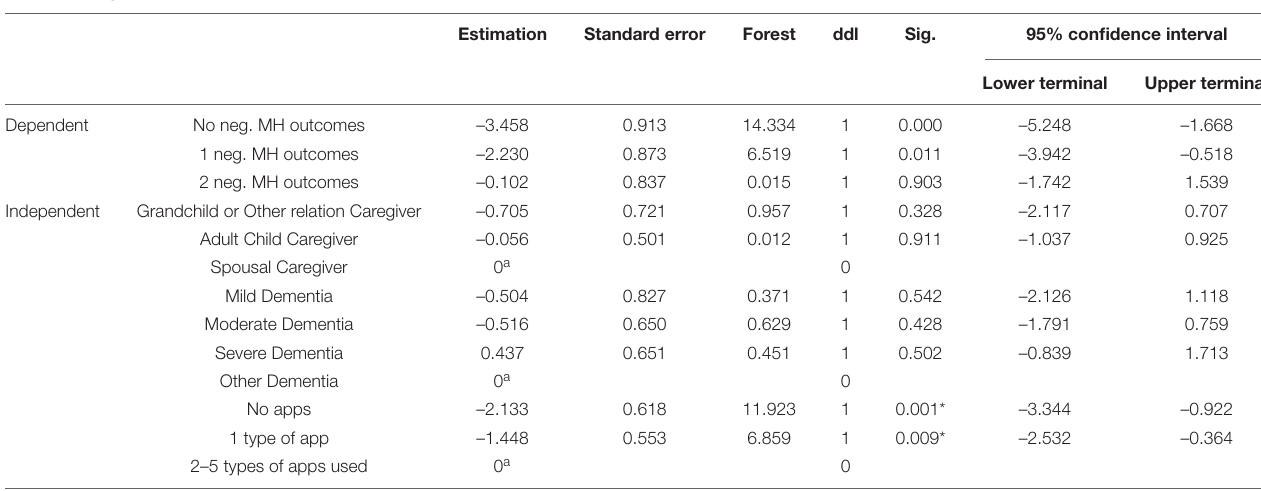
TABLE 2 | Ordinal regression analysis. Estimates of parameters